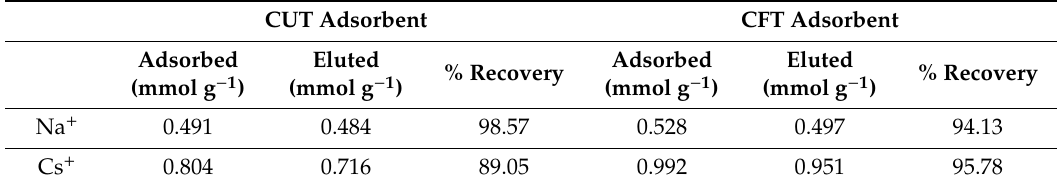
CFT and CUT respectively represents the crosslinked fresh and use tea leaves. Table 4. Separation and removal of Cs + from the mixture of Na + ions.